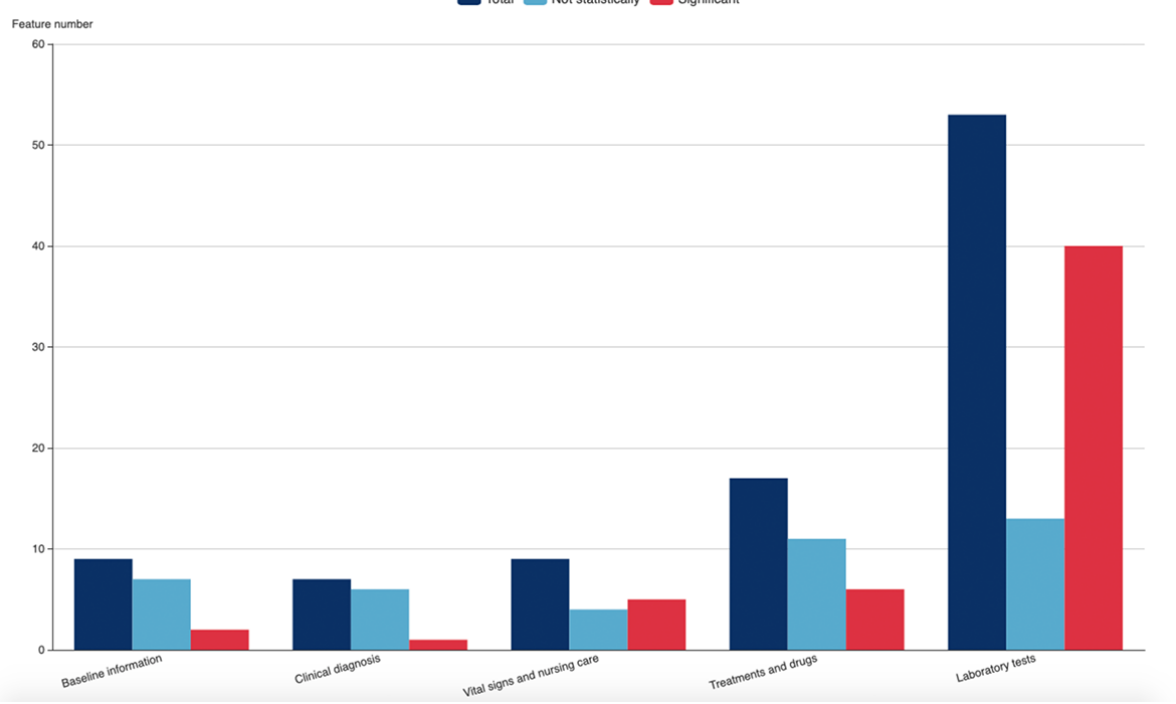
Figure 3. Statistical analysis of the screening results of all potential risk factors in the study cohort. The figure shows the screening of candidate variables